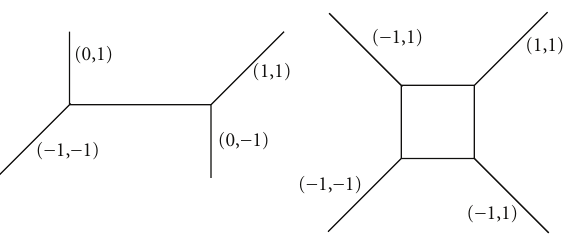
Figure 2: Toric webs of O (cid:6) − 1 (cid:7) ⊕ O (cid:6) − 1 (cid:7) and local CP 1 × CP 1 .